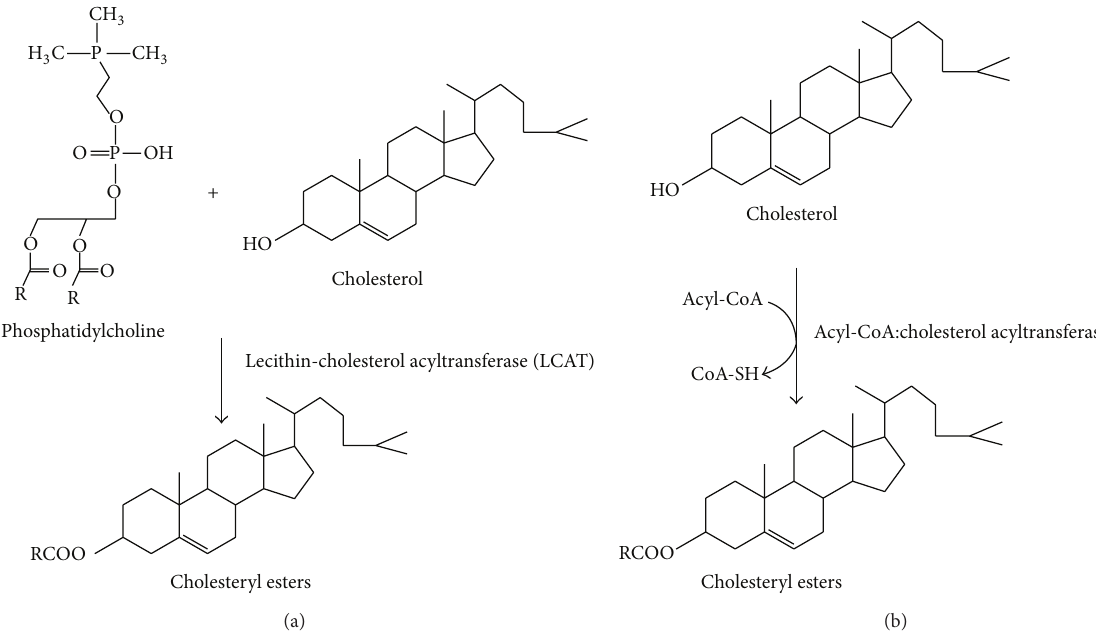
Figure 1: Biosynthesis of cholesterol esters (CEs) in human by two enzymes: lecithin-cholesterol acyl transferase (LCAT) (a) and acyl- coA:cholesterol acyltransferase (ACAT)